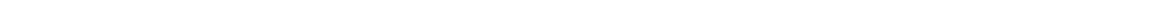
Fig. 4 Downregulation of IKK/NF- κ B pathway in neurons during in vitro and in vivo excitotoxicity parallels PKD inactivation. a (Top panel) Representative p-PKD(S916), PKD, p-IKK(S176/S177), IKK, and NSE (loading control) immunoblot analysis of cortical neurons stimulated with NMDA for the indicated times and (bottom panel) quanti fi cation of IKK activity after normalizing p-IKK(Ser176/177) densitometric values with those of total IKK and NSE. For each time point, p-IKK values were represented as fold increase relative to untreated cultures ( n = 5 independent experiments). b Representative images of MAP2, NF- κ B, and DAPI staining of cortical neurons treated with NMDA for 1 or 2 h. Zoom-boxed regions are also shown. (Right panel) Number of neurons bearing NF- κ B nuclear staining before and after NMDARs overstimulation relative to untreated cells ( n = 50 – 100 neurons per condition; n = 3 independent experiments). c Cortical neurons were transfected with tk-Luc and (NF- κ B)3-tk-Luc reporter vectors. Luciferase activity was measured after 48 h in unstimulated neurons or stimulated with NMDA 3 h. Fire fl y luciferase activity was normalized to that of Renilla luciferase activity in each sample, and expressed relative to that of tk-Luc control ( n = 3 independent experiments). d RT-qPCR analysis of Sod2 and Bdnf mRNA levels in cortical neurons untreated or treated with NMDA for 2 h shown relative to untreated neurons ( n = 3 independent experiments). e Representative confocal images of NeuN, NF- κ B, and DAPI staining in cortex of sham- or MCAO-operated animals. Zoom-boxed regions are also shown. (Right panel) Percentage of NF- κ B nuclear staining in the penumbra cortical zone from MCAO brain relative to the equivalent region from sham-operated animals ( n = 100 neurons, n = 3 sections per animal, n = 3 animals per condition). f Representative images of maximal projections and orthogonal views of a z -stack for double NF- κ B/NeuN and NF- κ B/DAPI staining of postmortem brain samples from control subjects (left panels) and ischemic stroke patients (medium panels). Images correspond to samples C-1 and S-2 (Supplementary Table 1). (Right panel) Percentage of neurons bearing nuclear NF- κ B ( n = 30 – 50 neurons per section; n = 3 individuals per condition). For quanti fi cations, mean ± s.e.m. were derived from the indicated number of independent experiments or samples and analyzed with two-tailed unpaired Student's t test. * P < 0.05, ** P < 0.01, *** P <